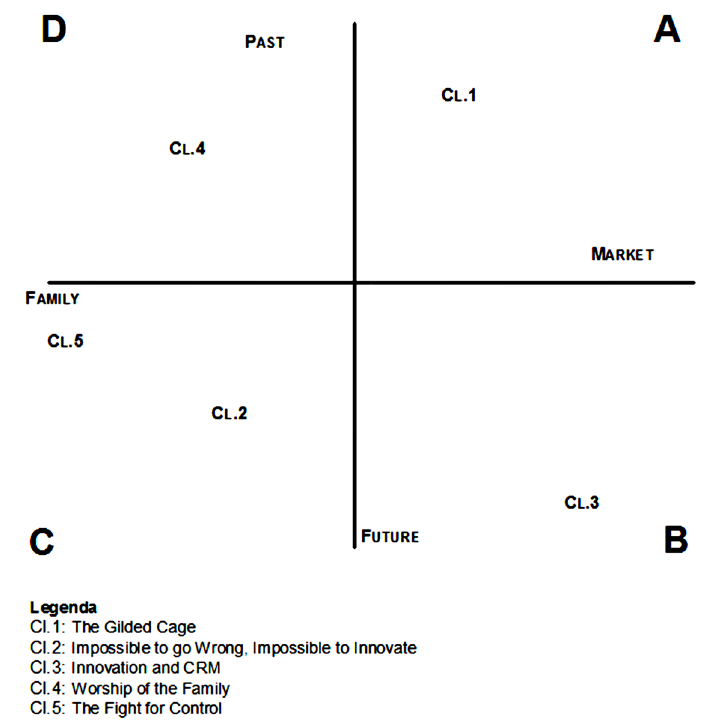
Figure 2. Representation of the X-Y Plane.